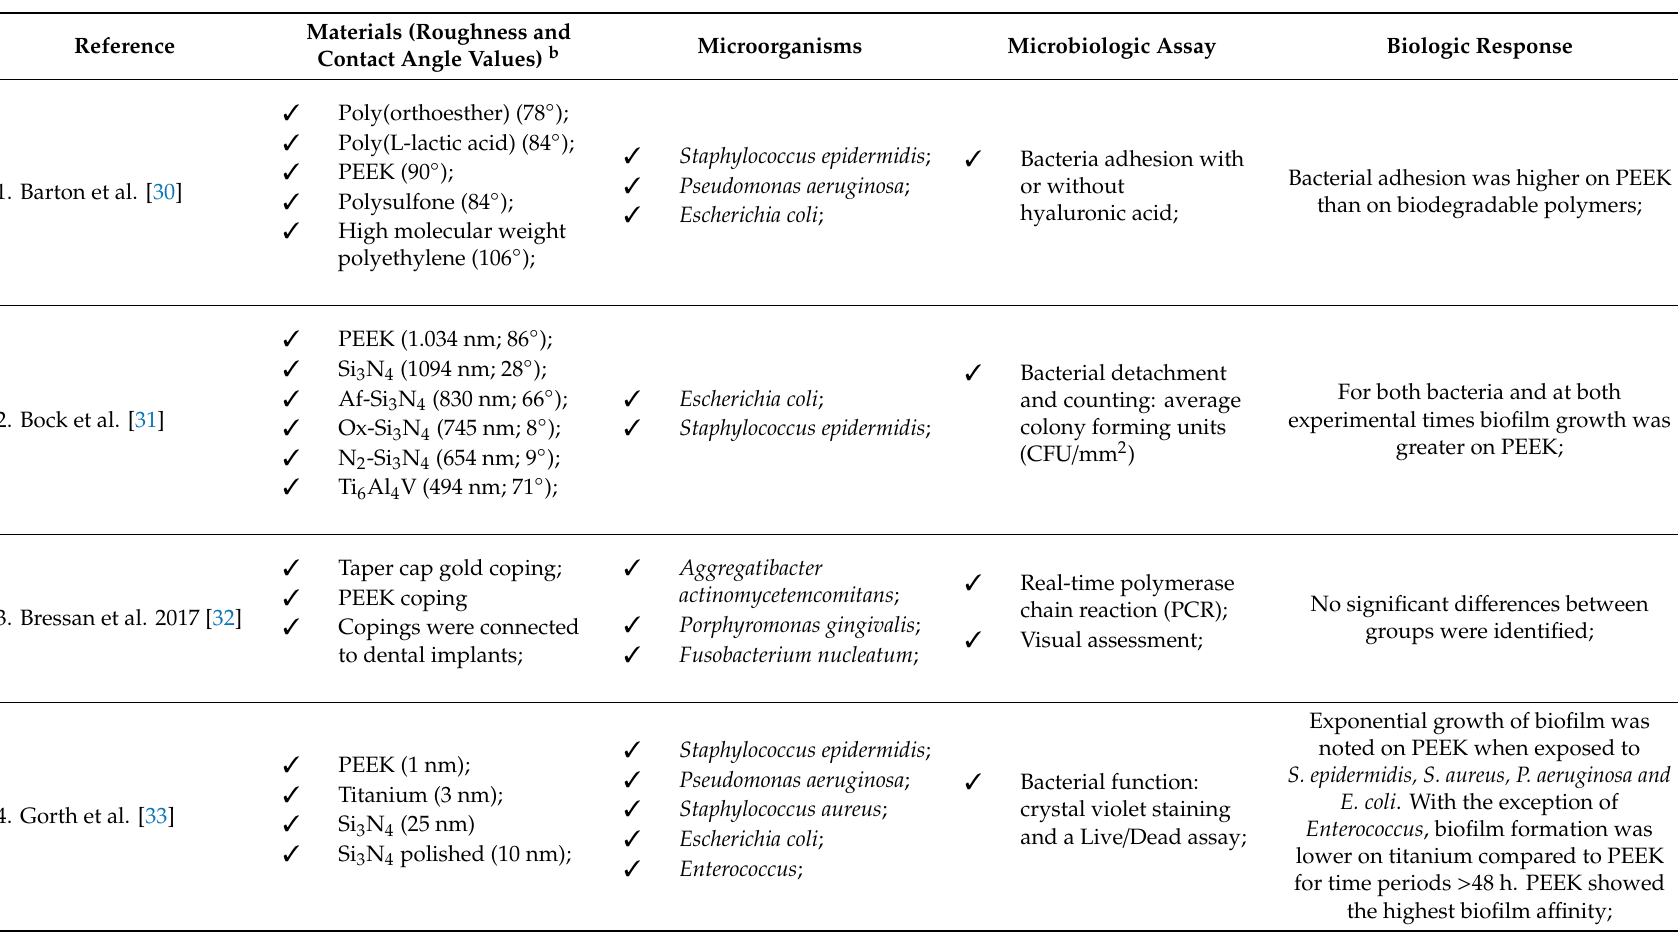
Table 1. Descriptive analysis of unmodified PEEK materials a